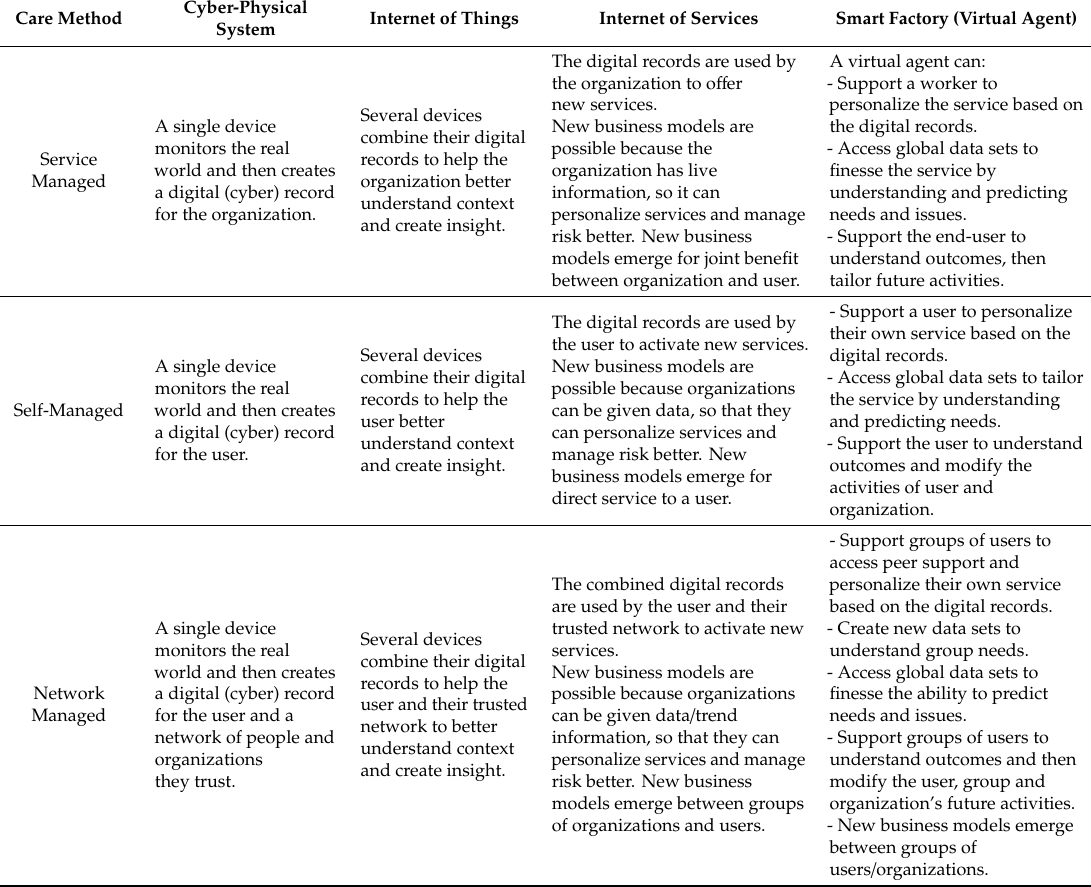
Table 4. The 4.0 toolset applied across care